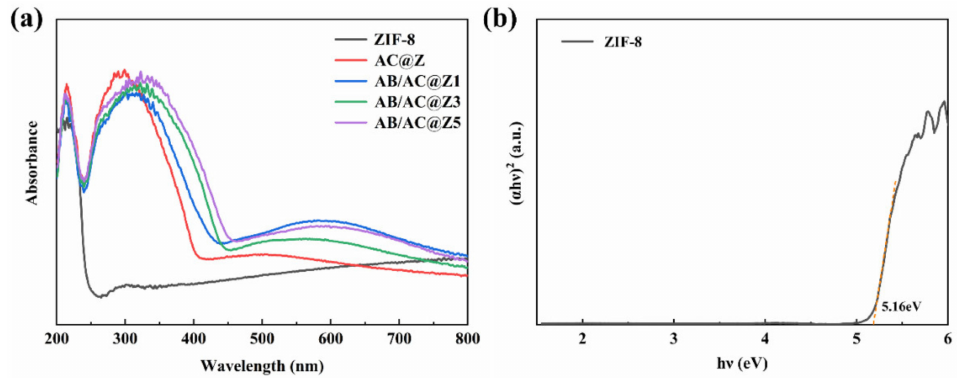
Figure 5. ( a ) The UV-DRS for the photocatalytic materials. ( b ) Plots of ( α h ν ) vs. h ν for